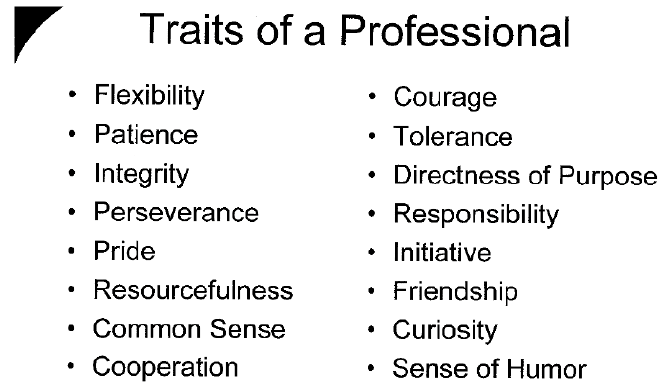
Fig. 4. Highlighted Professional Traits from Capstone Seminar